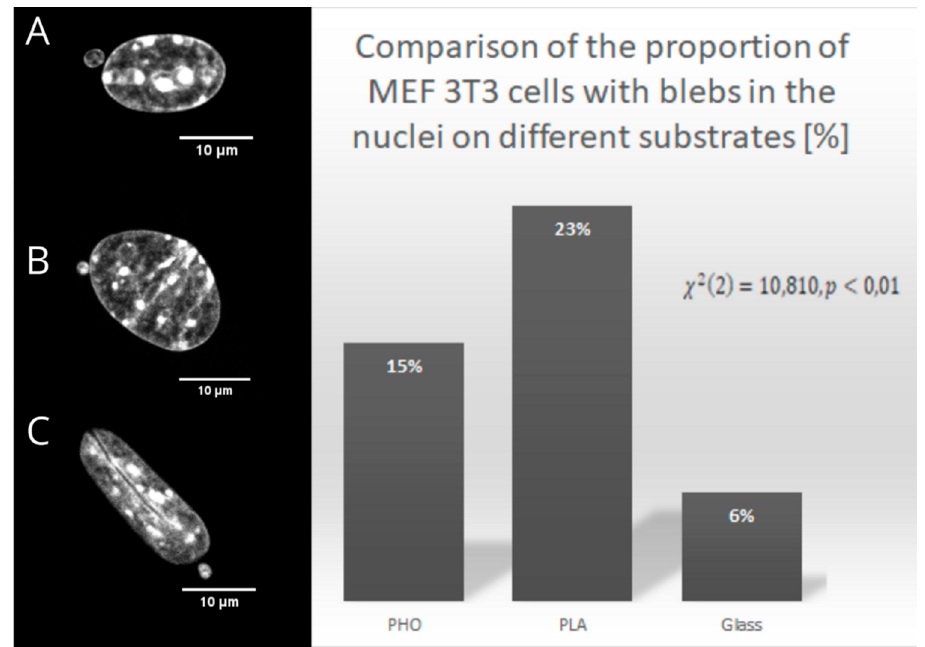
Figure 6. Examples of nuclear blebs for cells cultured on PHO ( A ), PLA ( B ), and glass ( C ). The graph presents the percentage of the cells in groups cultured on PHO, PLA, and Glass.